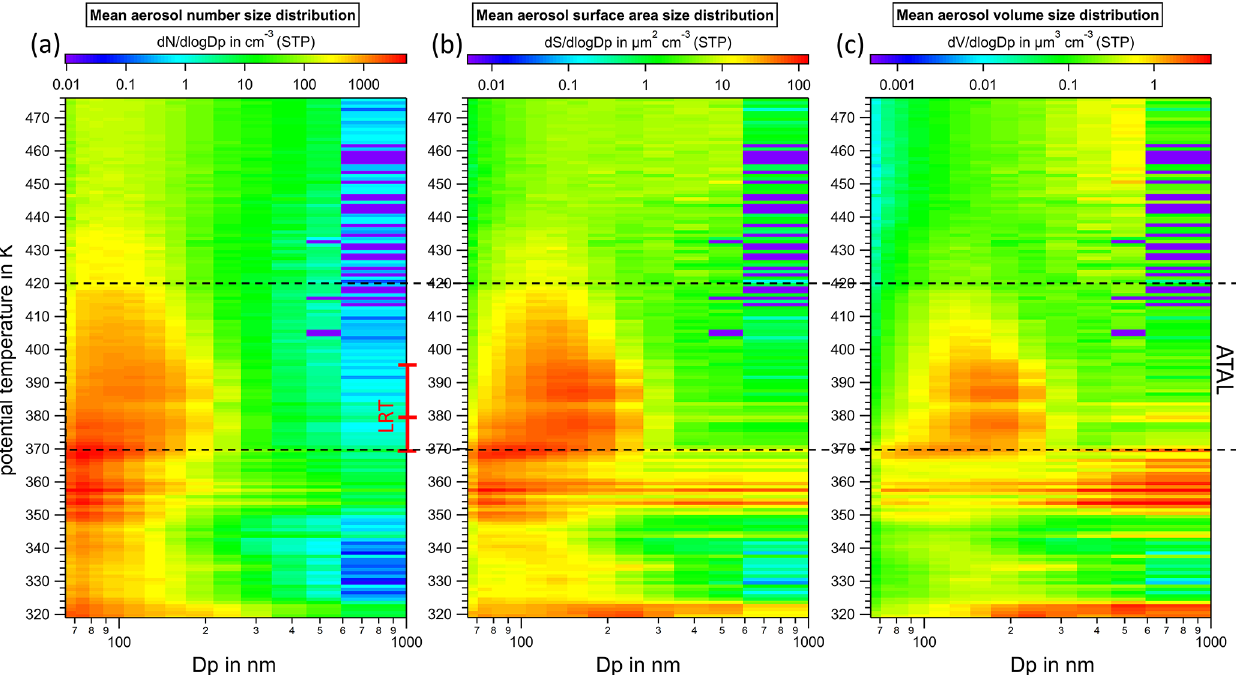
Figure 5. Vertical profile of (a) the aerosol particle number size distribution, (b) the aerosol particle surface area size distribution, and (c) the aerosol particle volume size distribution measured by the UHSAS-A during the 2017 StratoClim field campaign averaged over 1K potential temperature intervals. The color-coded concentrations for each size bin are converted from ambient conditions to standard temperature and pressure (STP). The red vertical bar indicates the position (minimum, mean, and maximum (cid:50) level) of the lapse rate tropopause (LRT; calculated from the reanalysis data) during the campaign period. The vertical region of the ATAL is indicated with black dashed lines.